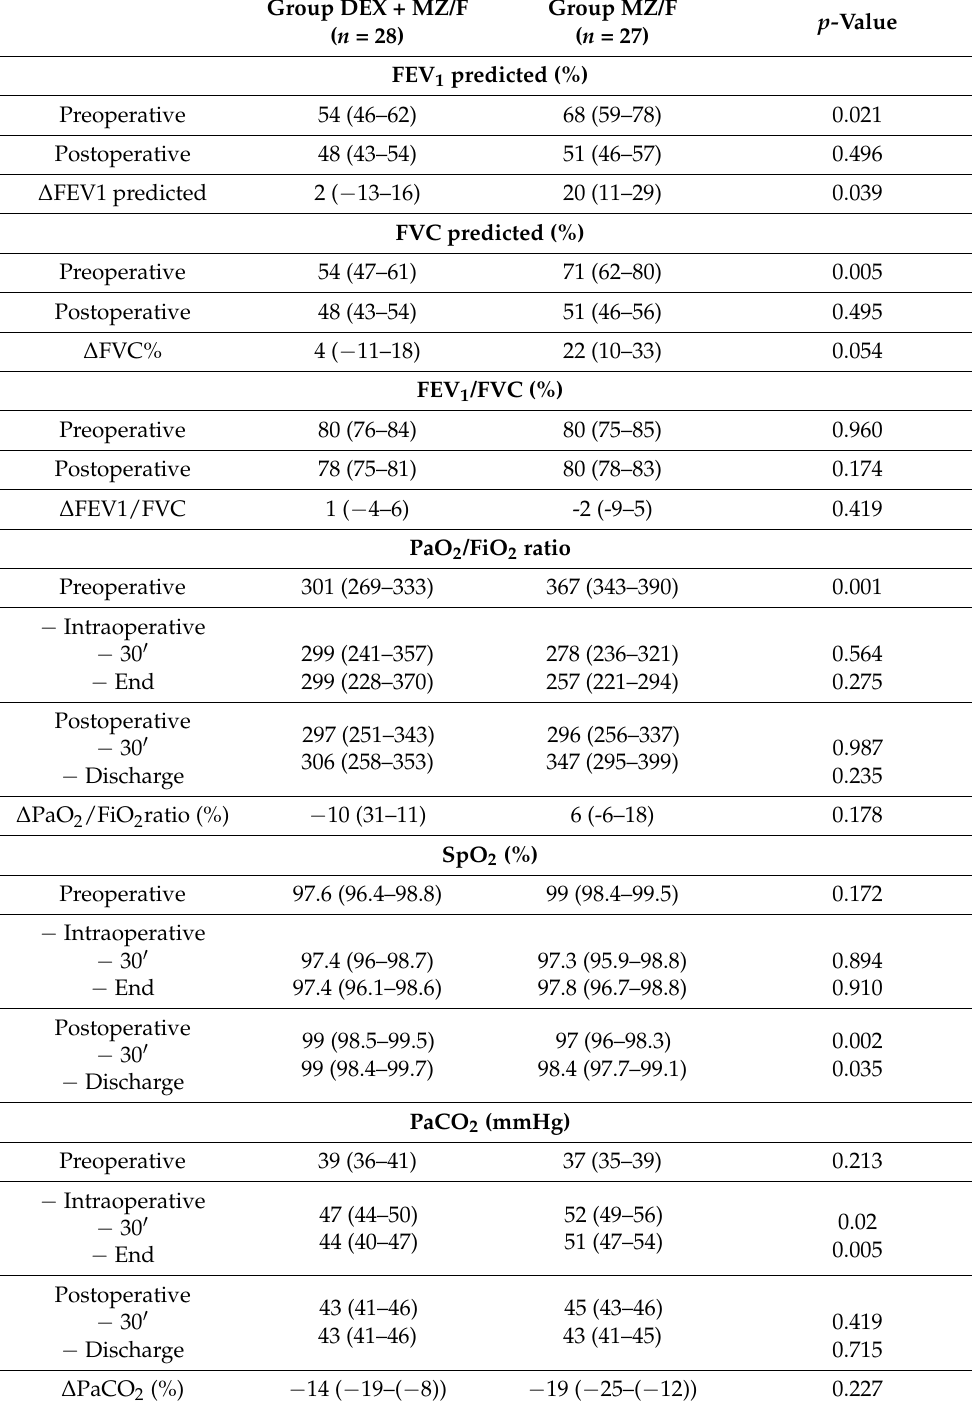
Table 2. Respiratory and Clinical